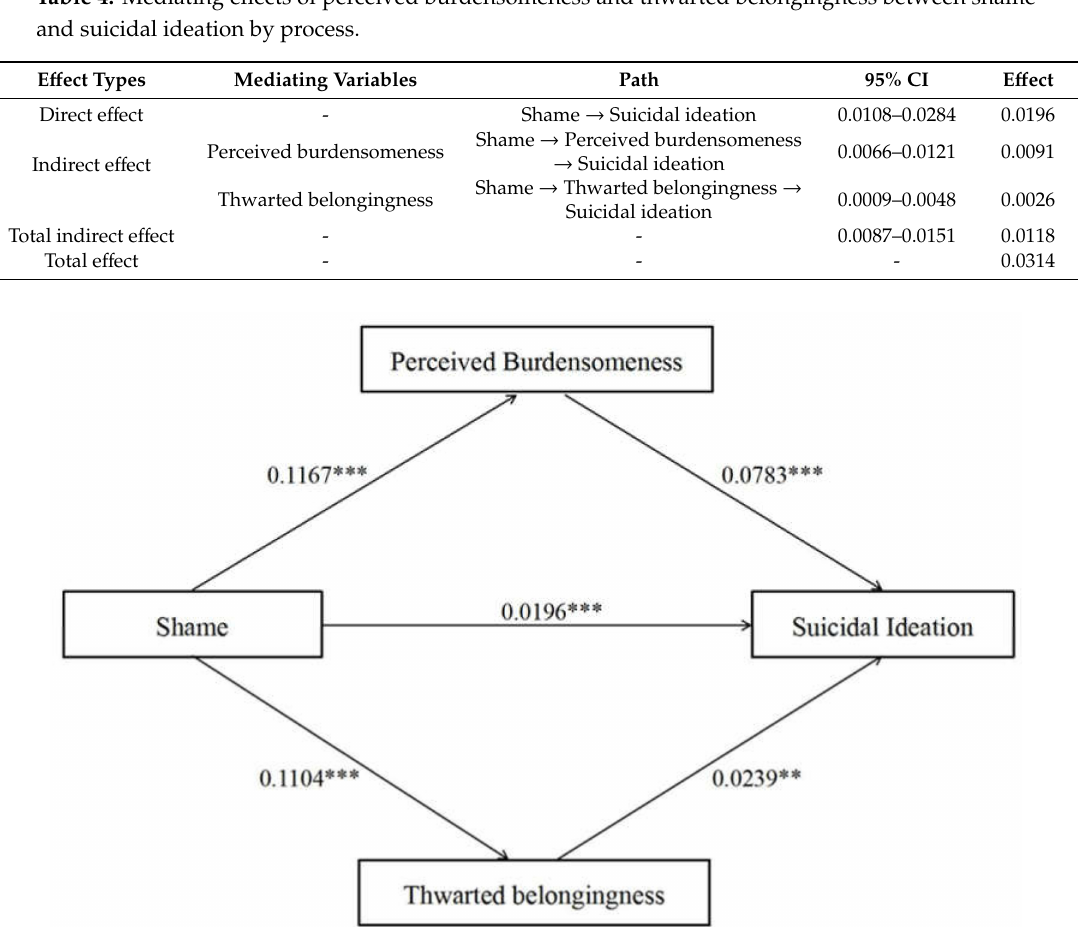
Figure 1. Mediating e ff ect analysis of perceived burdensomeness / thwarted belongingness between shame and suicidal ideation; ** p < 0.01; *** p <